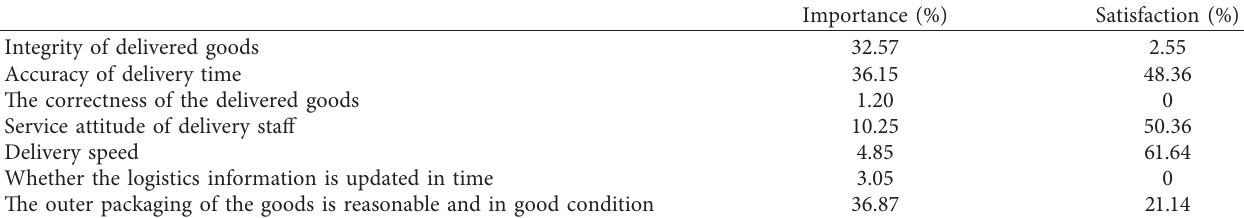
Table 6: Importance and satisfaction of factors affecting JD logistics service quality.